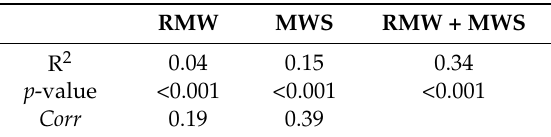
Table 2. The residuals of the regression of R33 onto the RMW, MWS and the residuals of the bivariate regression of R33 onto the RMW and MWS indices for the all experiments data. The correlation coefficient between R33 and RMW is 0.19 and 0.39 between R33 and